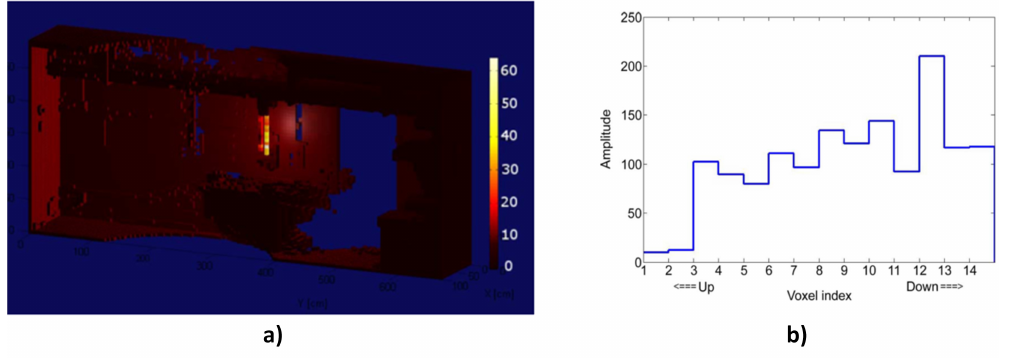
Figure 6. ( a ) Reconstructed image of contaminated environment shown in Figure 2a using the MSDF of the Compton camera and LiDAR images; ( b ) intensity of voxels from top to bottom around the pipe containing the line source